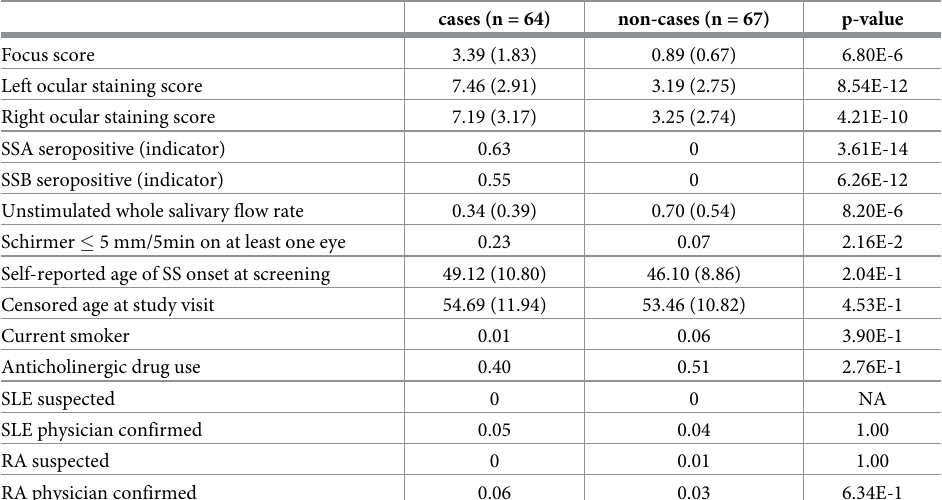
Table 1. Summary statistics of SS phenotypes, potential confounders, and